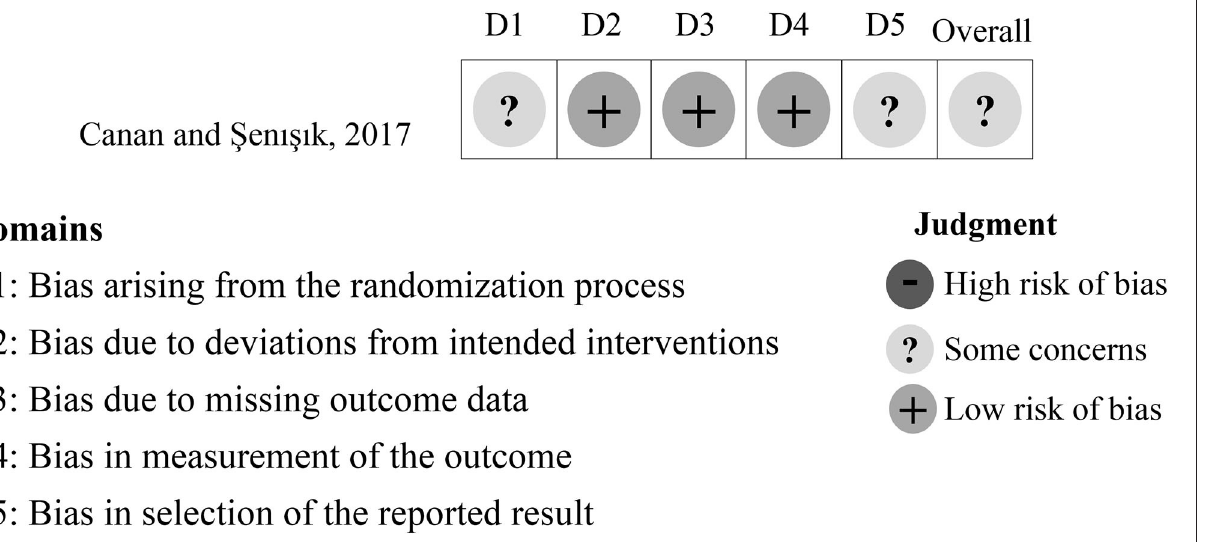
FIGURE 2 | Summary of the risk of bias assessment according to Cochrane Collaboration’s RoB 2